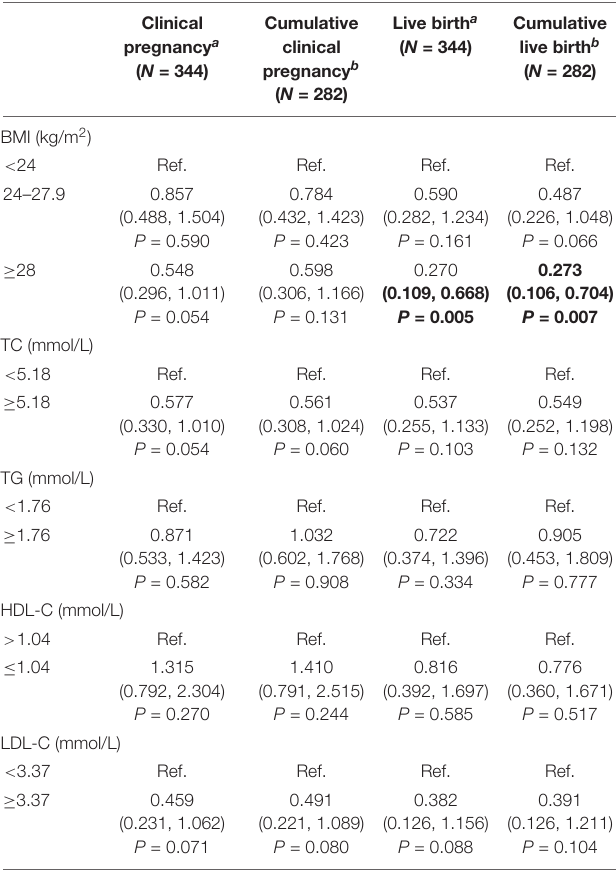
TABLE 5 | Binary logistic regression analysis of BMI, TC, TG, HDL-C, and LDL-C TABLE 4 | Embryo transfer cycle characteristics and clinical outcomes. for clinical outcomes in embryos transfer Median (Q1, Q3)or N (percentage)